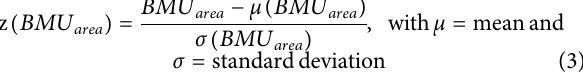
Frontiers in Earth Science |